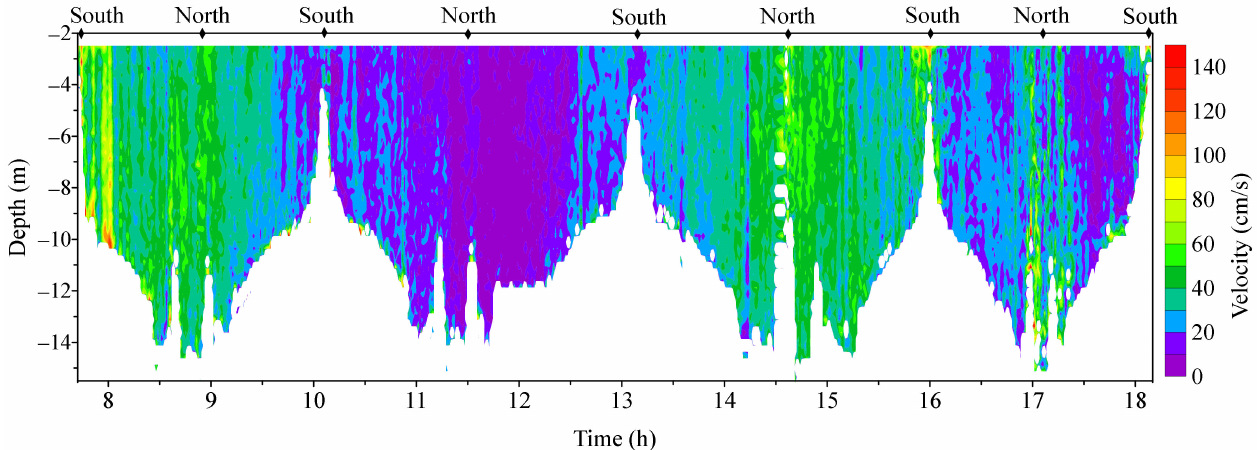
Figure 4. The current profiles observed by ADCP at the bay mouth, where little aquaculture existed. North and South represent the north and south ends (Figure 1c),